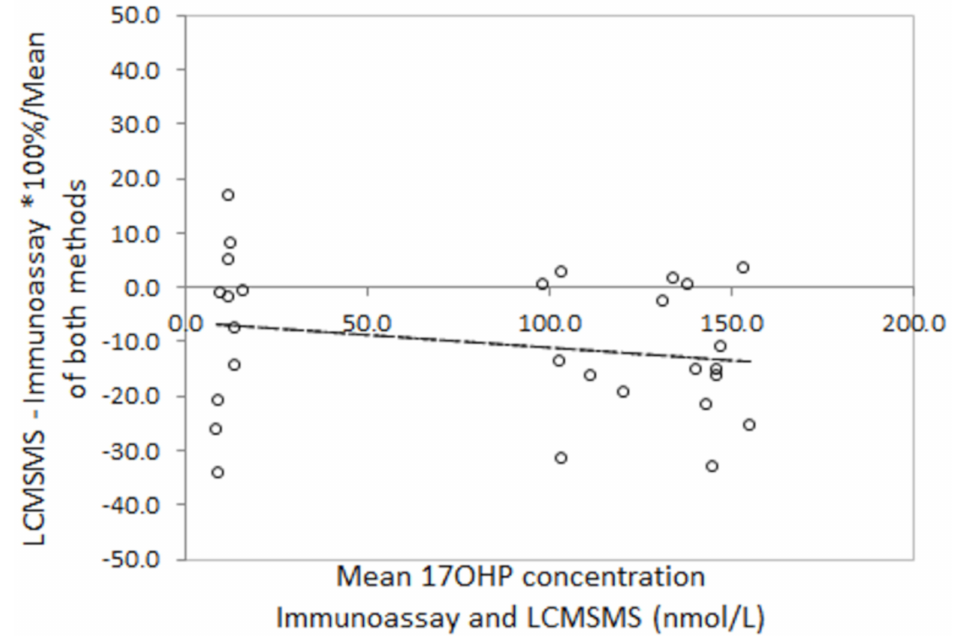
Figure 4. Bland Altman plots for LCMSMS and Immunoassay for external quality assurance samples ( n = 32). Slope = − 0.02 ( p = 0.52), mean di ff erence = − 11.1%, LOA = − 38.8 to